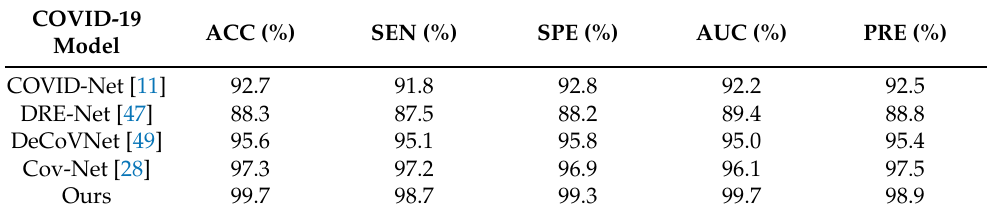
Table 9. Comparison of our proposed model with some COVID-19 models for binary class using the